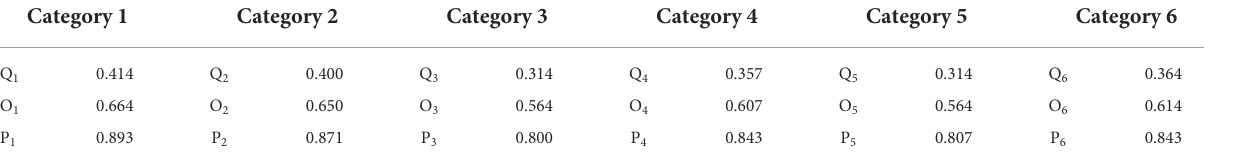
TABLE 4 Fuzzy number means for O ratings in